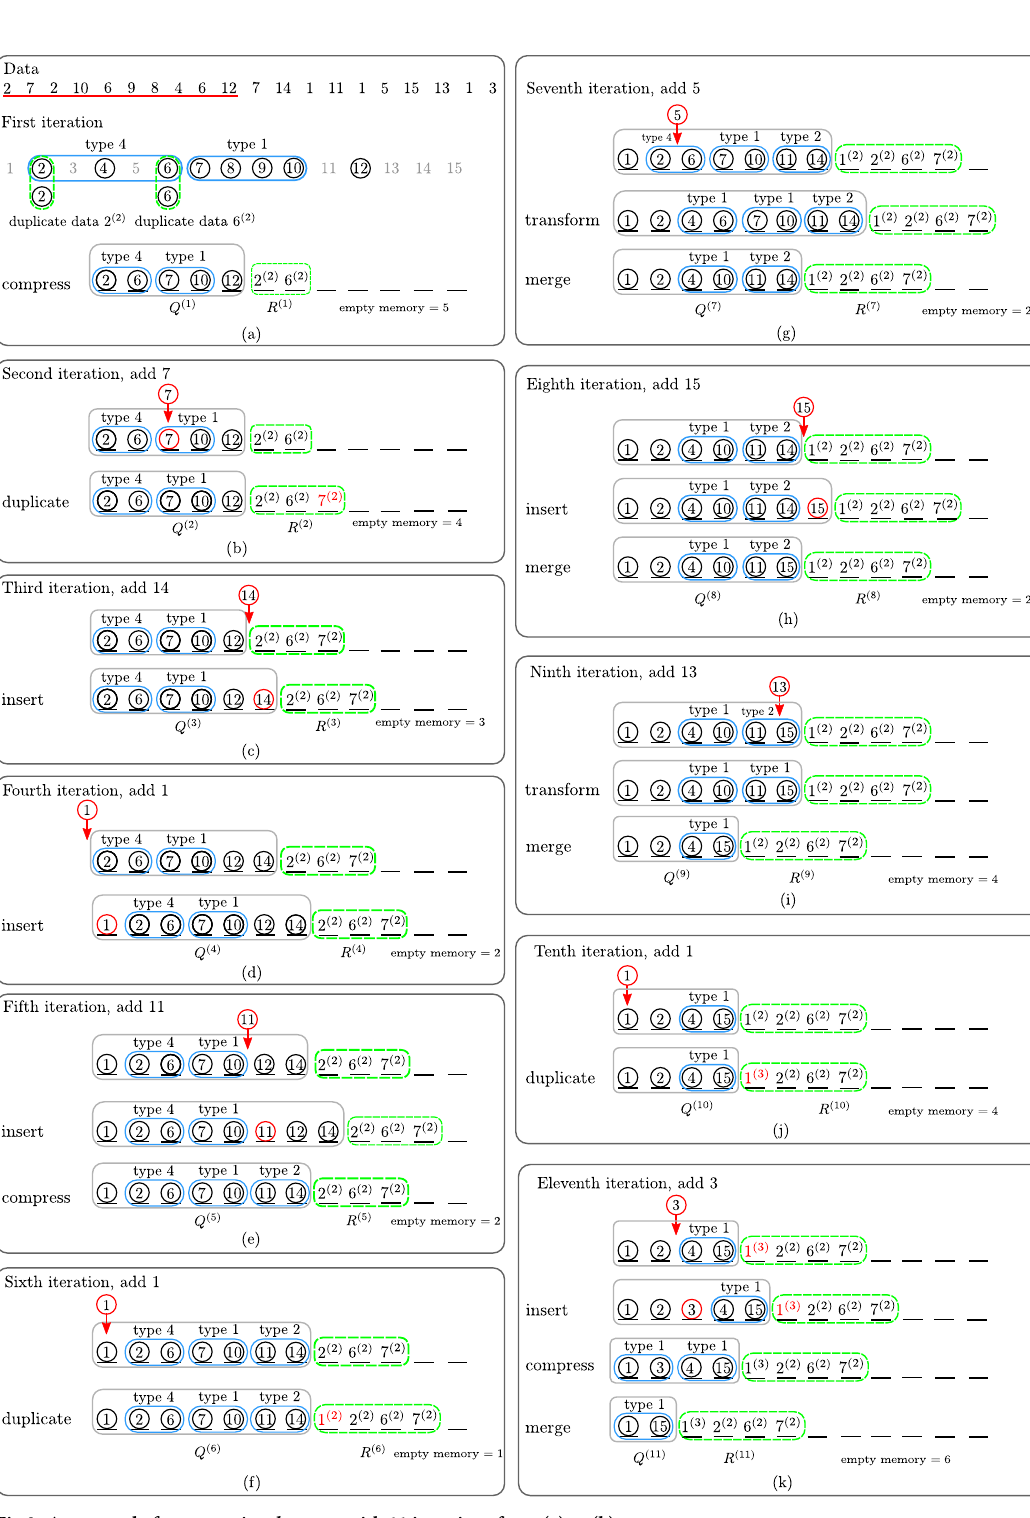
PLOS ONE | https://doi.org/10.1371/journal.pone.0266295 April 5,